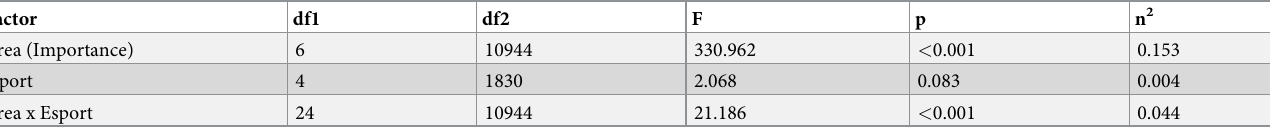
Table 15. Results of the two-factor ANOVA regarding training field importance in different esports.